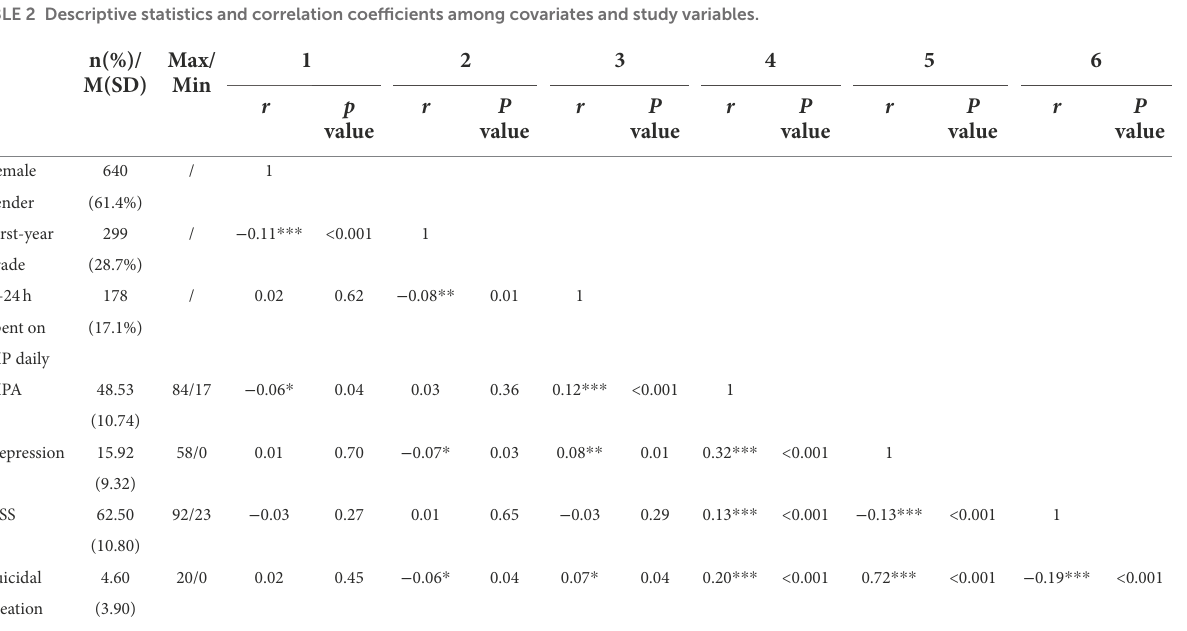
TABLE 2 Descriptive statistics and correlation coefficients among covariates and study variables.